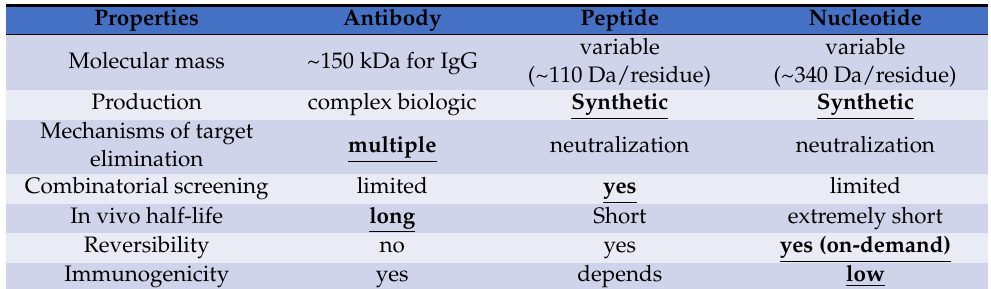
Table 1. A qualitative comparison of properties between antibody and middle-biomolecules as targeted drugs. The pros and cons between mAb, peptide, and nucleotide are described. Significant distinguishing features are noted in bold. In vivo half-life of the middle-biomolecules would be improved by attaching warheads to create bioTCIs; details are described in Section